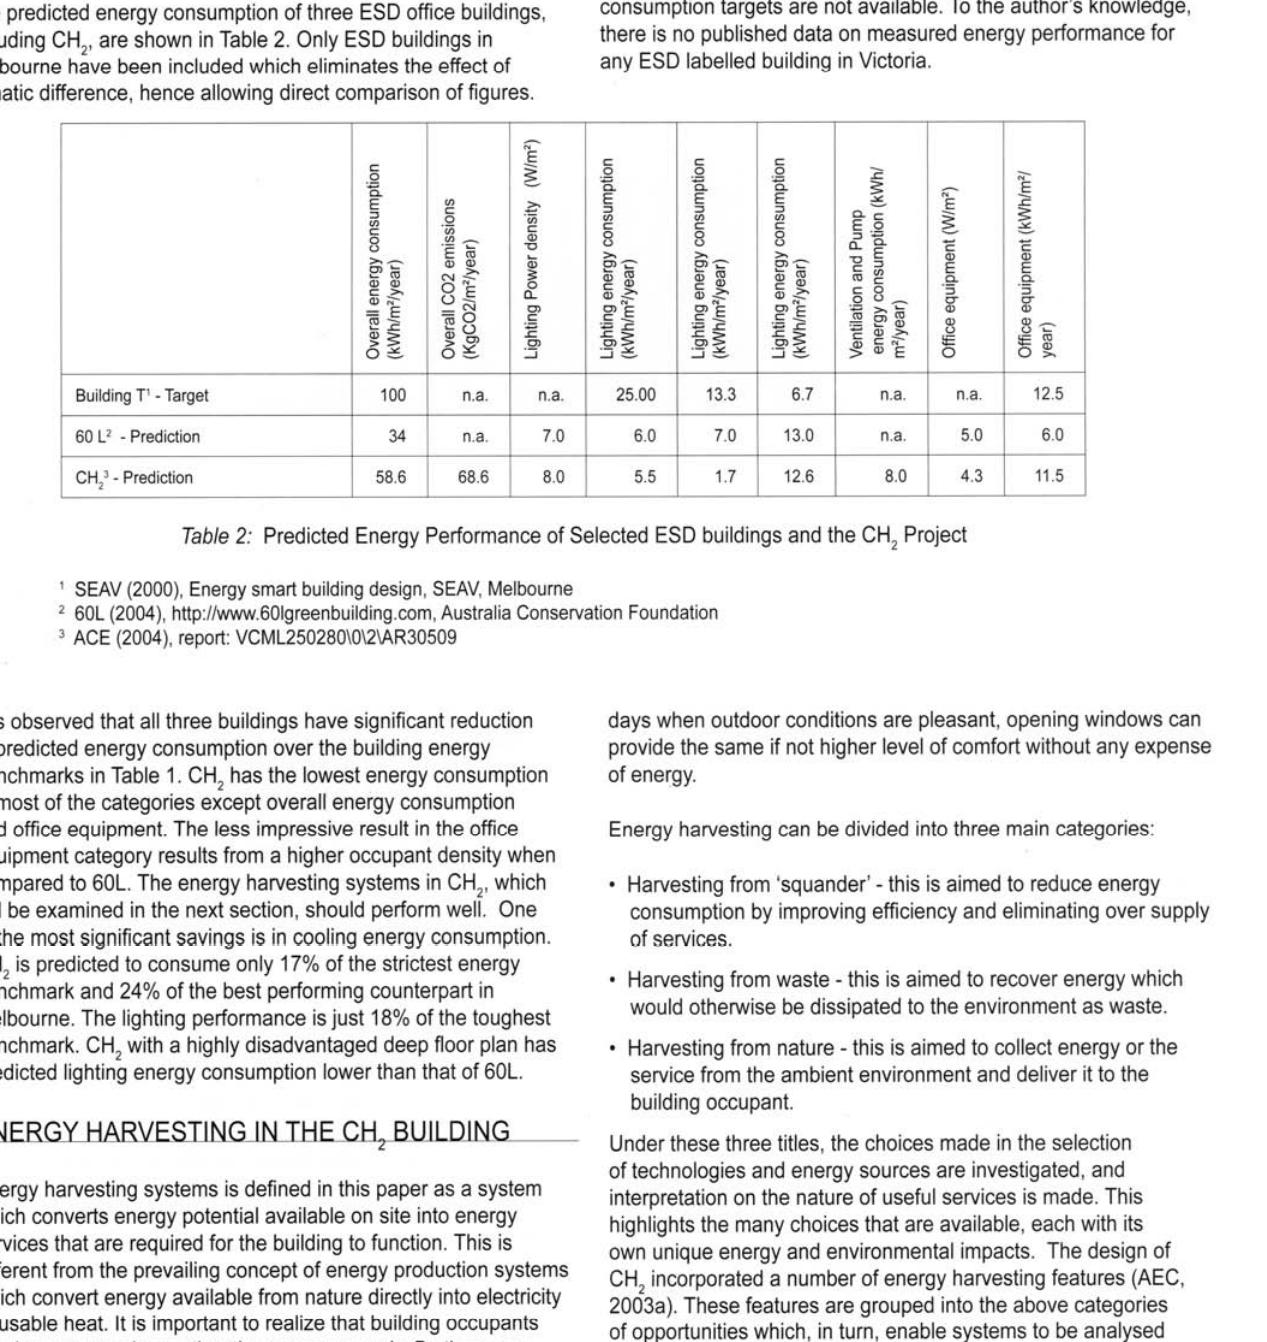
Table 2: Predicted Energy Performance of Selected ESD buildings and the CH